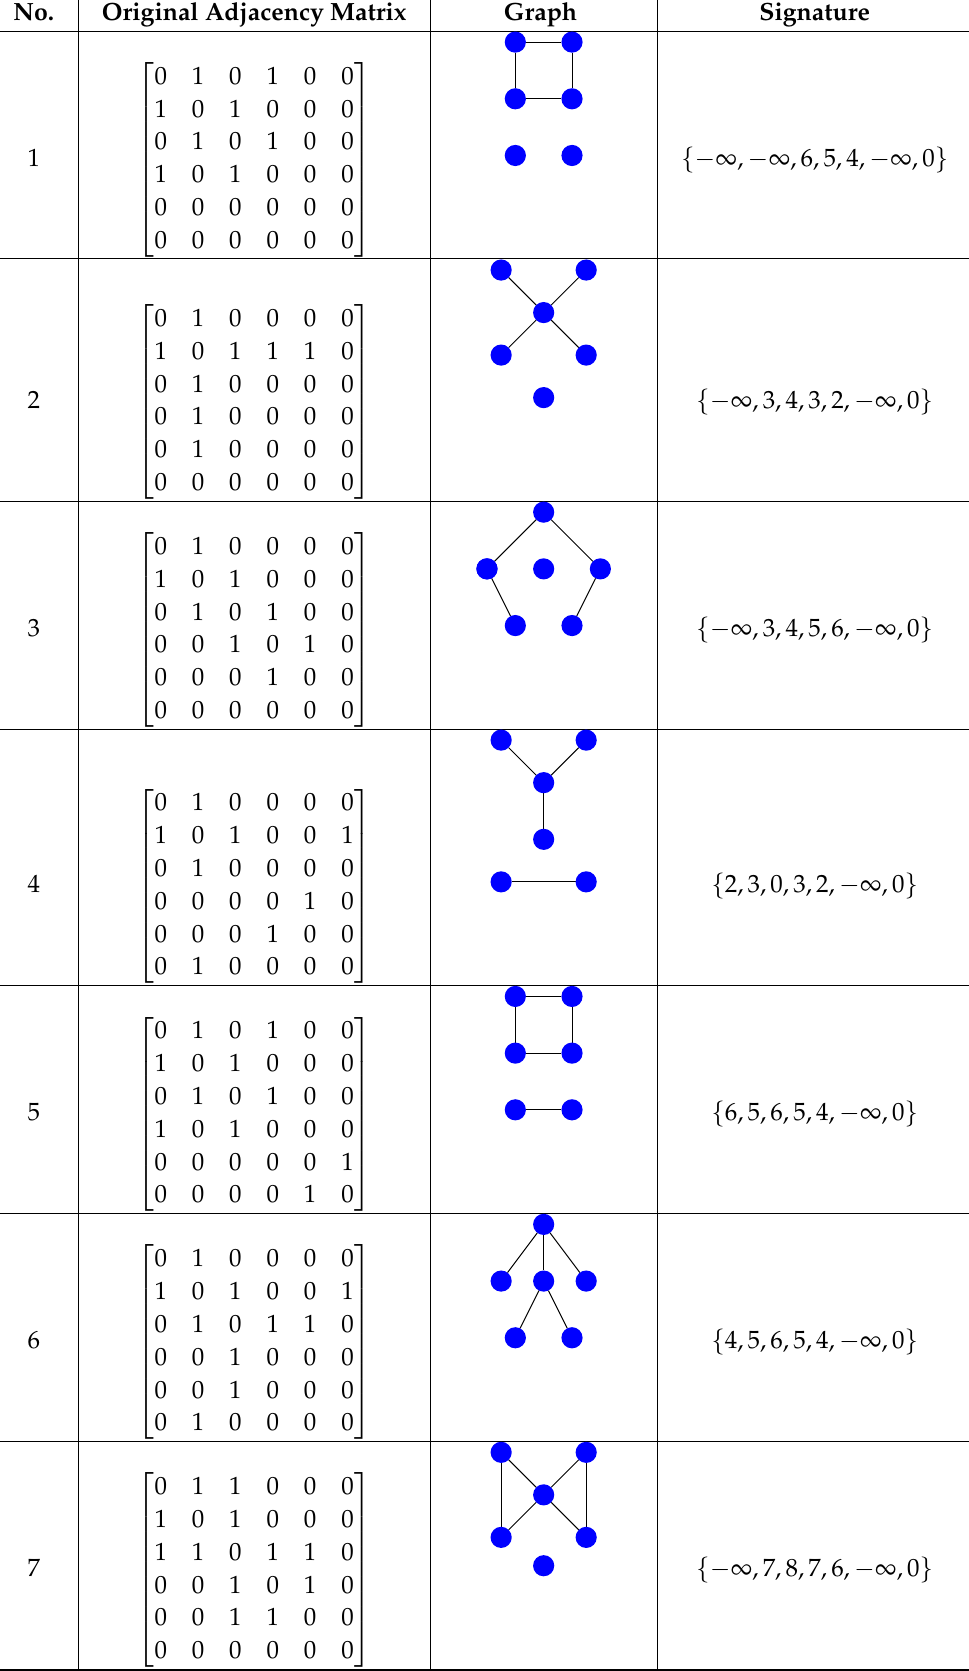
Table 1. All cospectral graphs with six